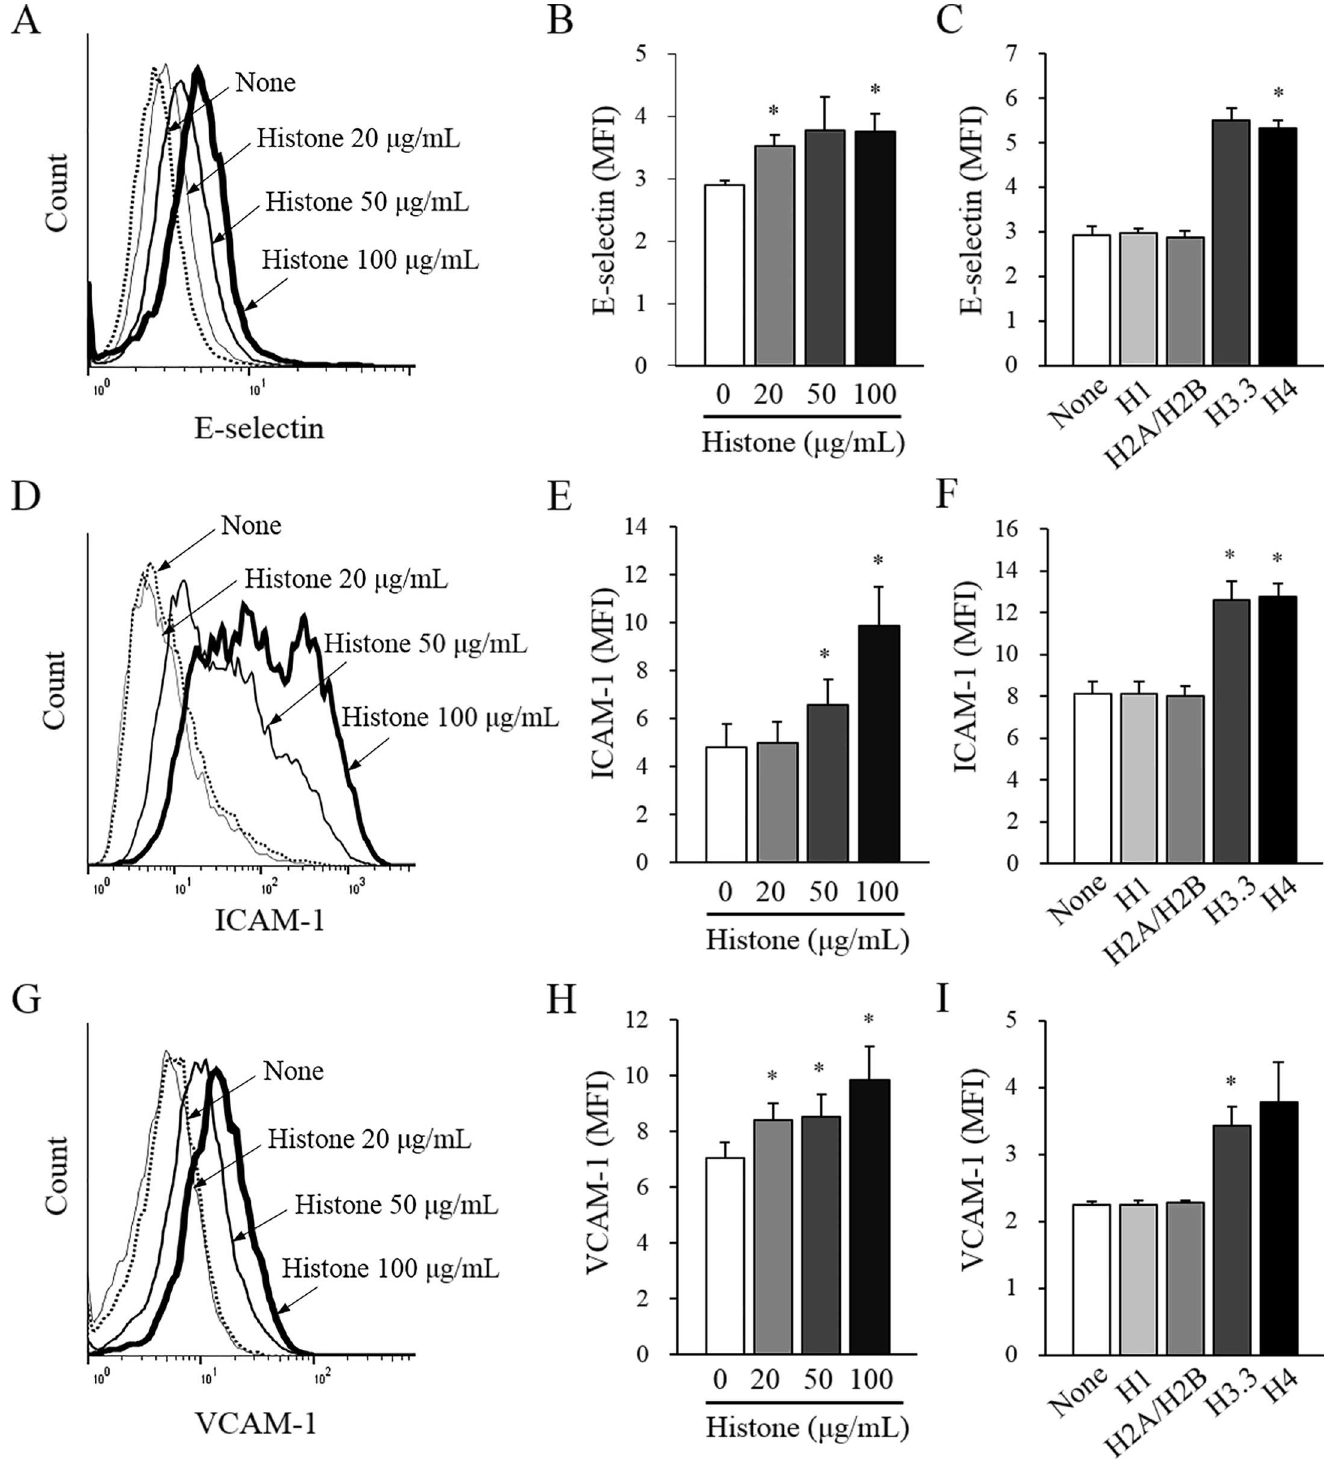
Fig 3. Histone induces surface expression of endothelial adhesion molecules. Endothelial cells (EA.hy926) were cultured with various concentrations of calf thymus histone or 20 μ g/mL individualhuman recombinant histones (H1, H2A/H2B, H3.3, or H4) for 5 h and then the surface expressionof (A, B, C) E-selectin, (D, E, F) ICAM-1, and (G, H, I) VCAM-1 were determined by flow cytometry. Histograms are representative of four independent experiments. The bars indicate mean fluorescence intensity (MFI) of each adhesion molecule ± SEM of 4 experiments. * P < 0.05 versus no histone